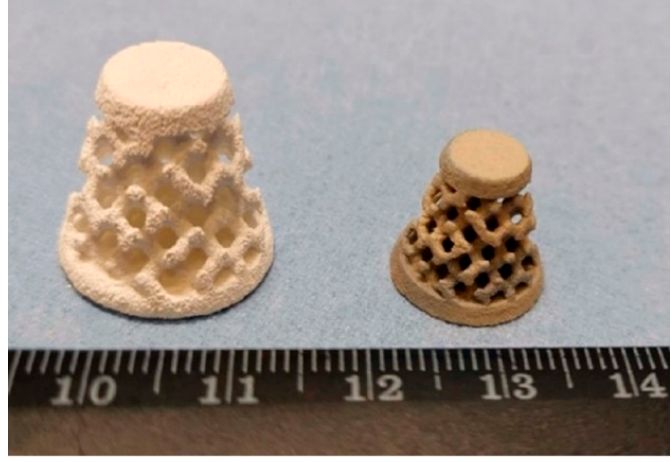
Figure 24. Image of FGP samples with controlled gradient porosity printing by BJ before (left) and after sintering (right) (available under Creative Commons license